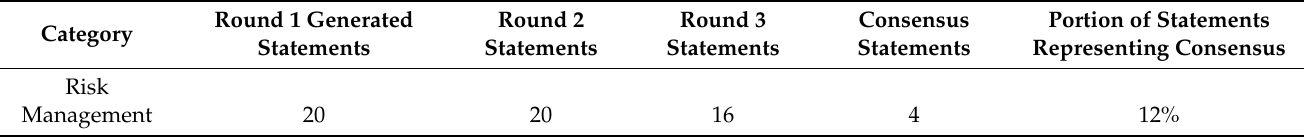
Table 2 contains data corresponding to the voting results from each round of the study. Table 1. Overall Study Findings.